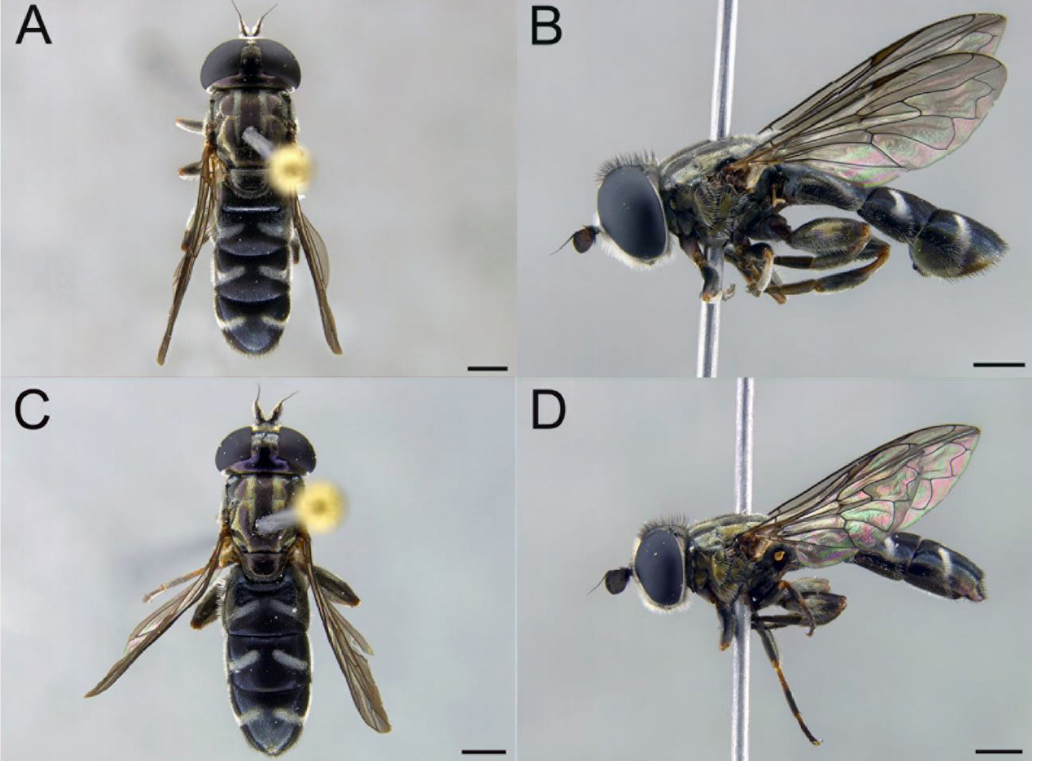
Fig. 2. Eumerus colladoi Ricarte & Aguado-Aranda sp. nov. A . Holotype, ♂, dorsal view (CEUA- CIBIO). B . Holotype, ♂, lateral view. C . Paratype, ♀, dorsal view (CEUA-CIBIO). D . Paratype, ♀, lateral view view (CEUA-CIBIO). Scale bars = 1